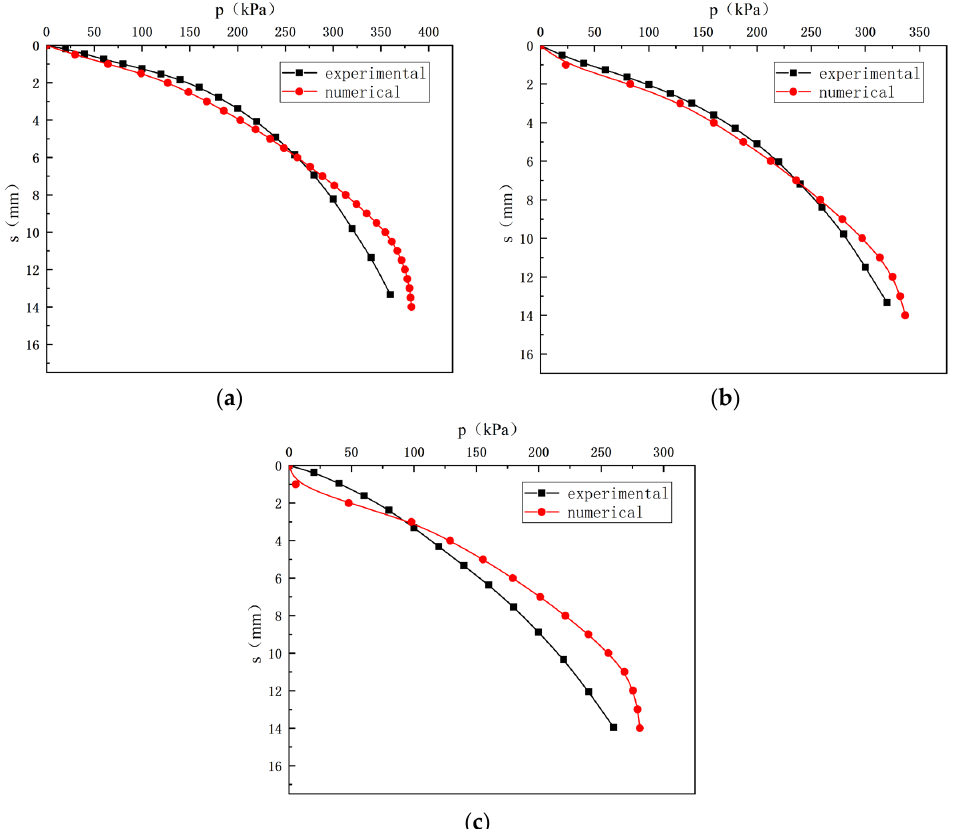
Figure 10. Comparison of test and simulation results at different water-level heights: ( a ) initial water level, ( b ) 50 mm water level and ( c ) 100 mm water level. level, ( b ) 50 mm water level and ( c ) 100 mm water